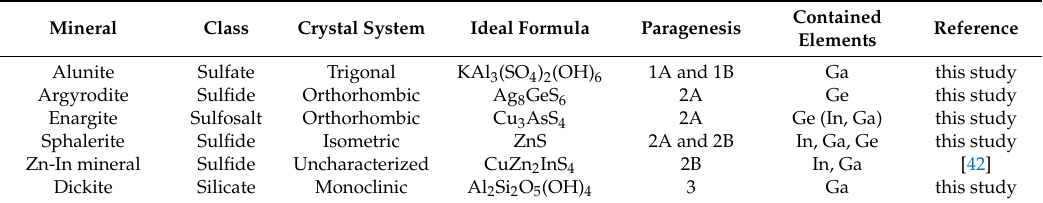
Table 1. List of critical element-bearing minerals identified at the Mt Carlton